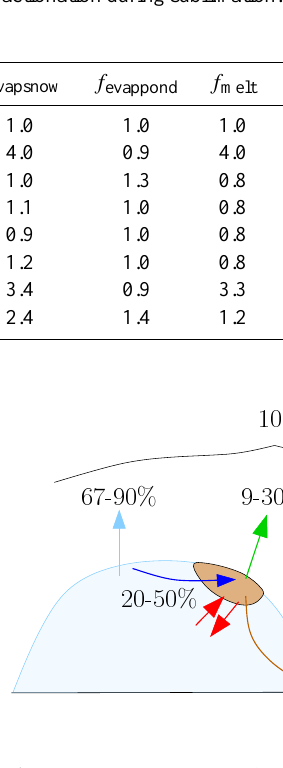
Fig. 12. The partitioning of fluxes as described by an optimal fit of all model solutions to the observed isotopic constraints. Results are expressed as the percentage of the total surface water flux. The range is given as the maximum and minimum values from all simu- lations. The maximum likelihood estimates are given in Table